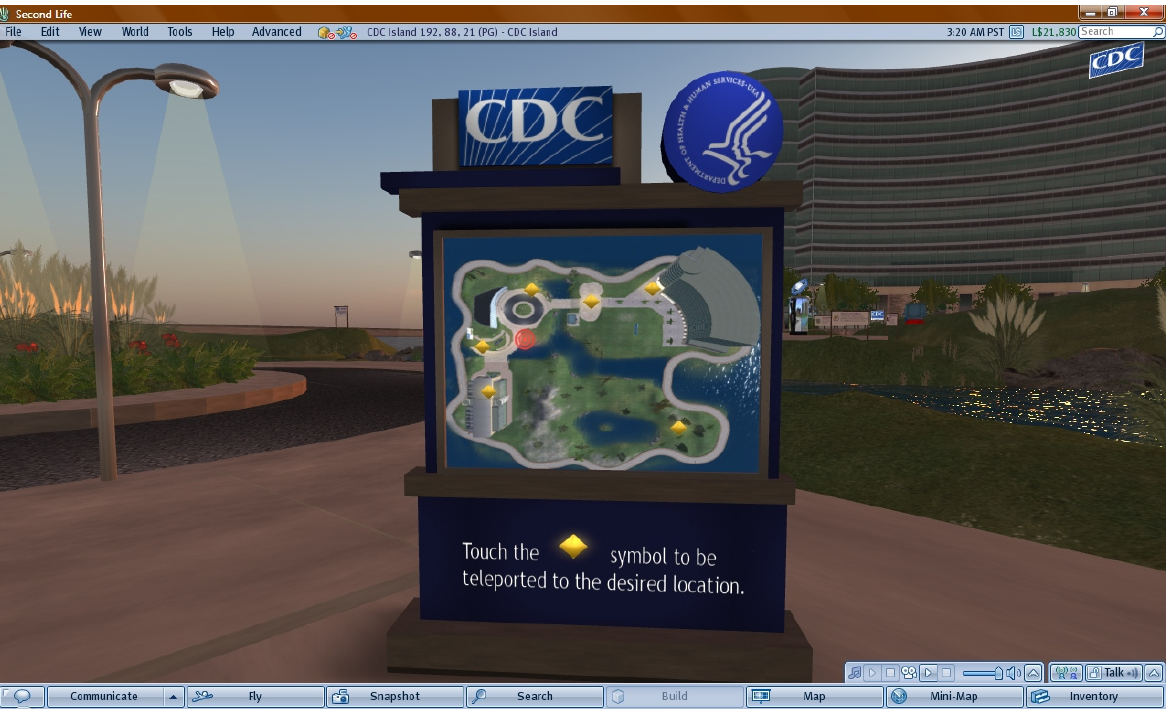
Figure 4. A teleport hub at the CDC Island in Second Life ® offering instant access (teleport) to the various places and buildings on the